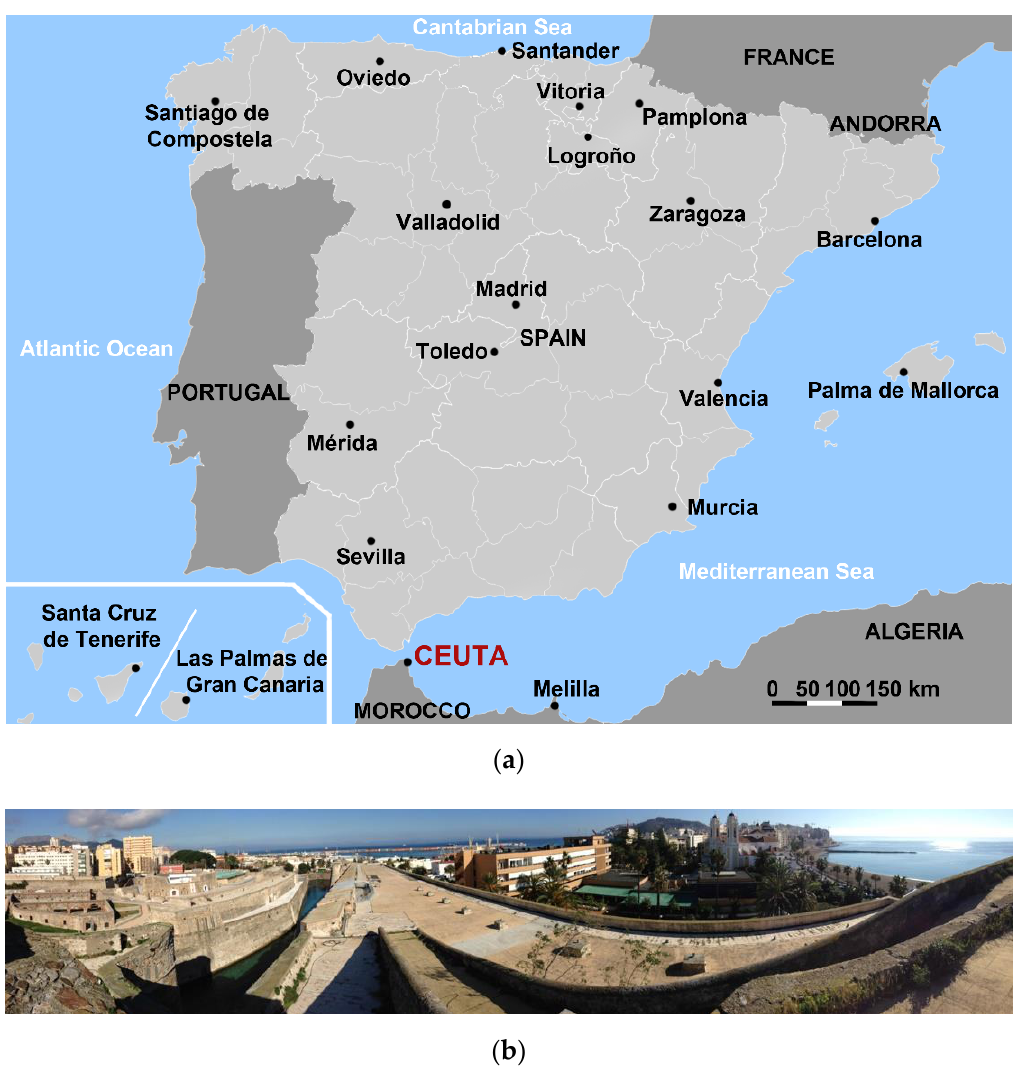
Figure 2. ( a ) Location of Ceuta. ( b ) General sight of the city and the royal walls.